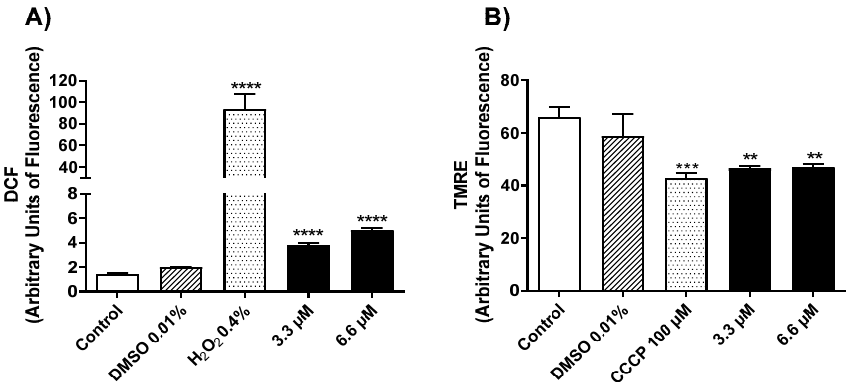
Figure 5. Mechanism of action induced by 4f in promastigote forms of L. amazonensis . Parasites were treated for 24 h with compound 4f (IC 50 and 2 × IC 50 ). ( A ) ROS determination using DCF fluorescence, ( B ) TMRE assays of the mitochondrial membrane potential. ** Significant difference compared to control ( p ≤ 0.01), *** ( p ≤ 0.001) and **** ( p ≤ 0.0001). 2.2.3. Morphological and Ultrastructural Changes in Promastigotes